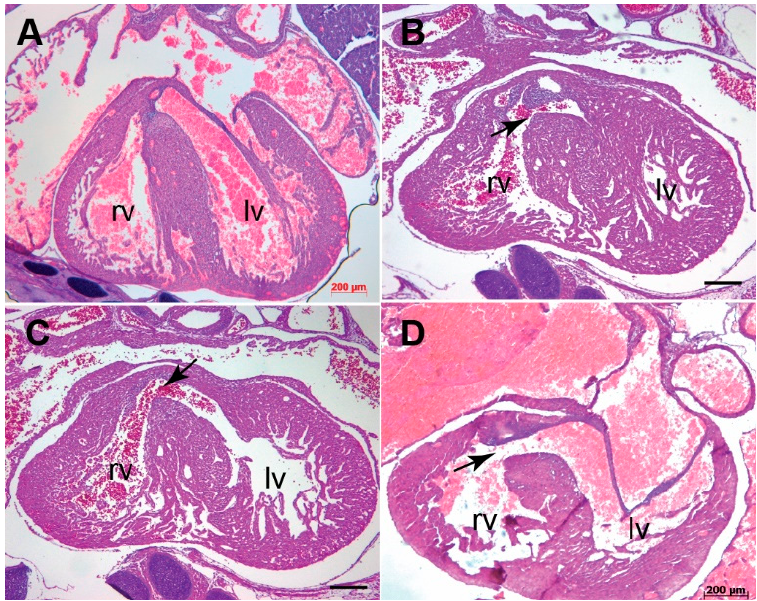
Figure 2. Tgfb3 knockout mouse fetuses exhibit outflow tract septal and alignment defects. ( A – D ), Hematoxylin and eosin staining of hearts for E15.5-16.5 wildtype ( A ) and two di ff erent Tgfb3 − / − fetuses ( B – D ). Tgfb3 − / − fetuses develop both double-outlet right ventricle ( B , arrow) and perimembranous ventricular septal defect ( C , D ; arrows). Scale bars = 200 µ m for ( A – D ). Abbreviations: rv, right ventricle; lv, left